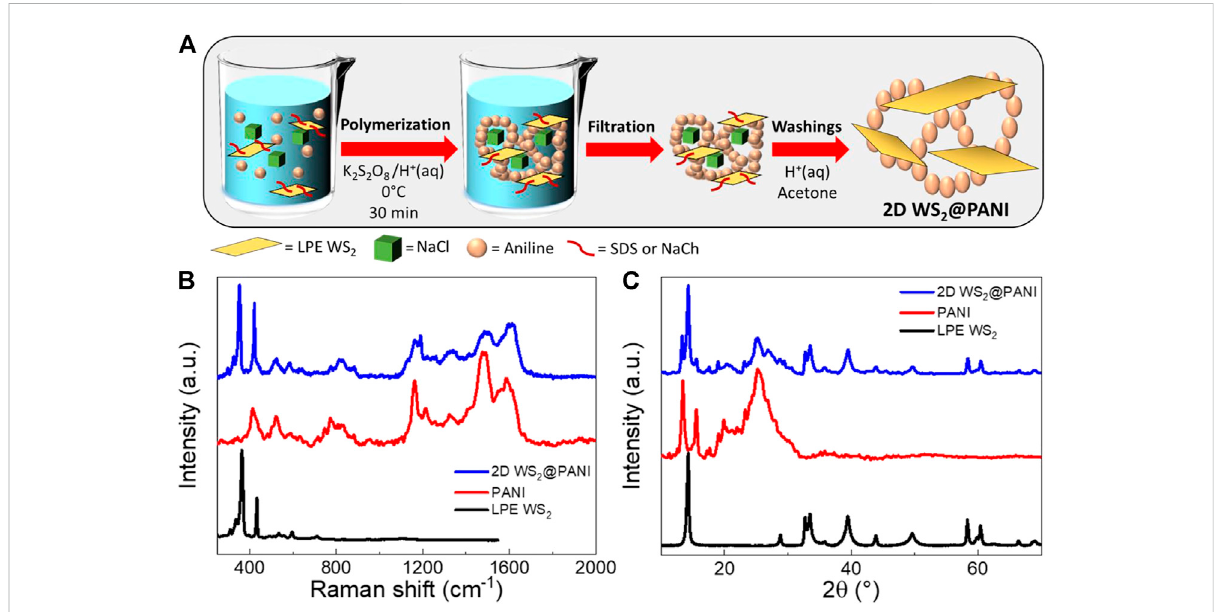
FIGURE 1 (A) Schematic representation of the template-assisted synthesis of nanostructured 2D WS 2 @PANI nanohybrids. (B) Raman spectra and (C) P-XRD diffractograms of the nanostructured 2D WS 2 @PANI nanohybrids, of template-assisted synthesized pure PANI and of LPE WS 2 (the P-XRD pattern of this last one has been obtained from the fi ltered powder).